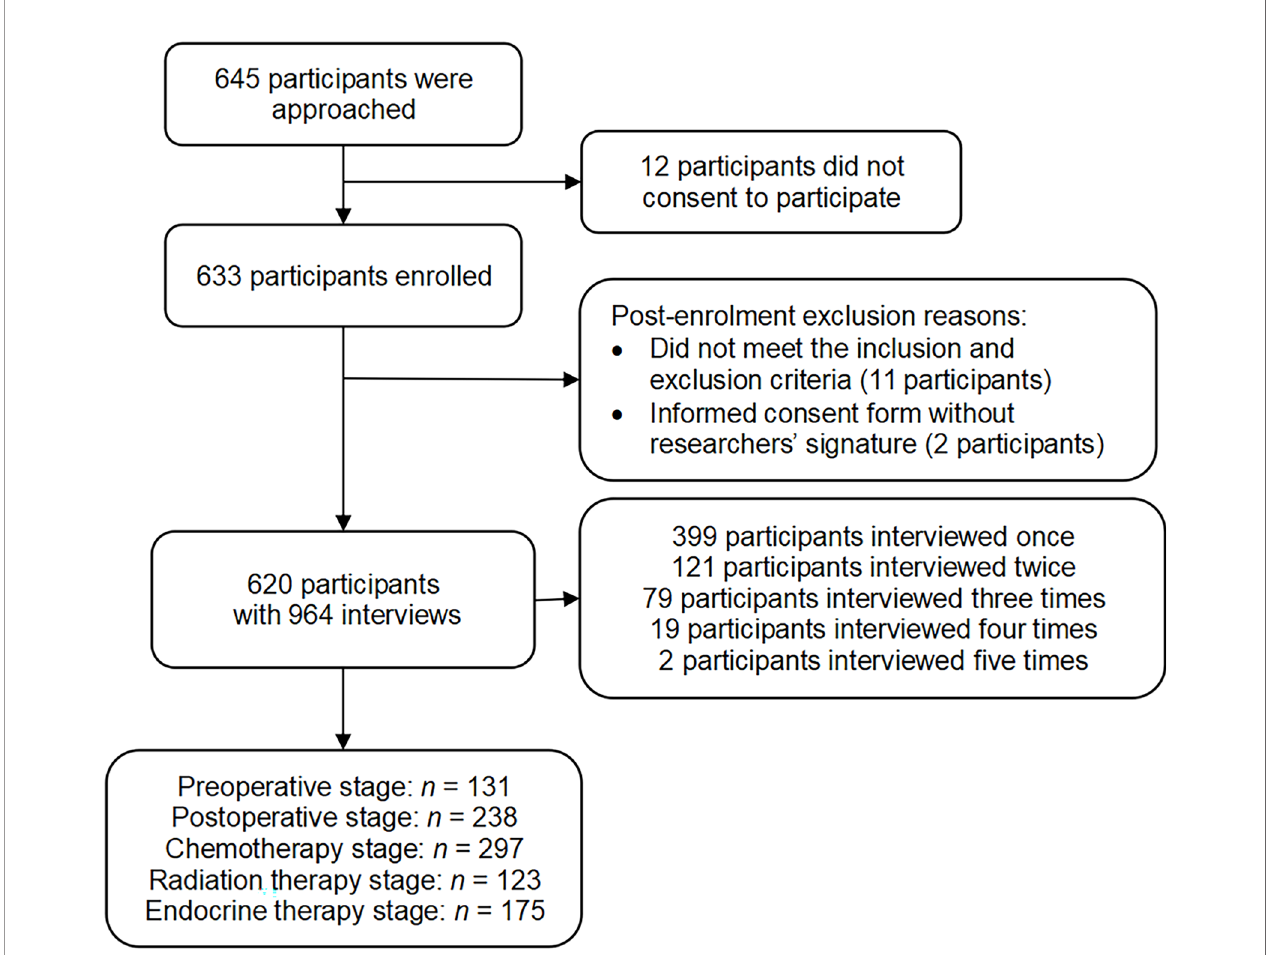
FIGURE 1 | Flowchart of the participant inclusion. n represents the number of